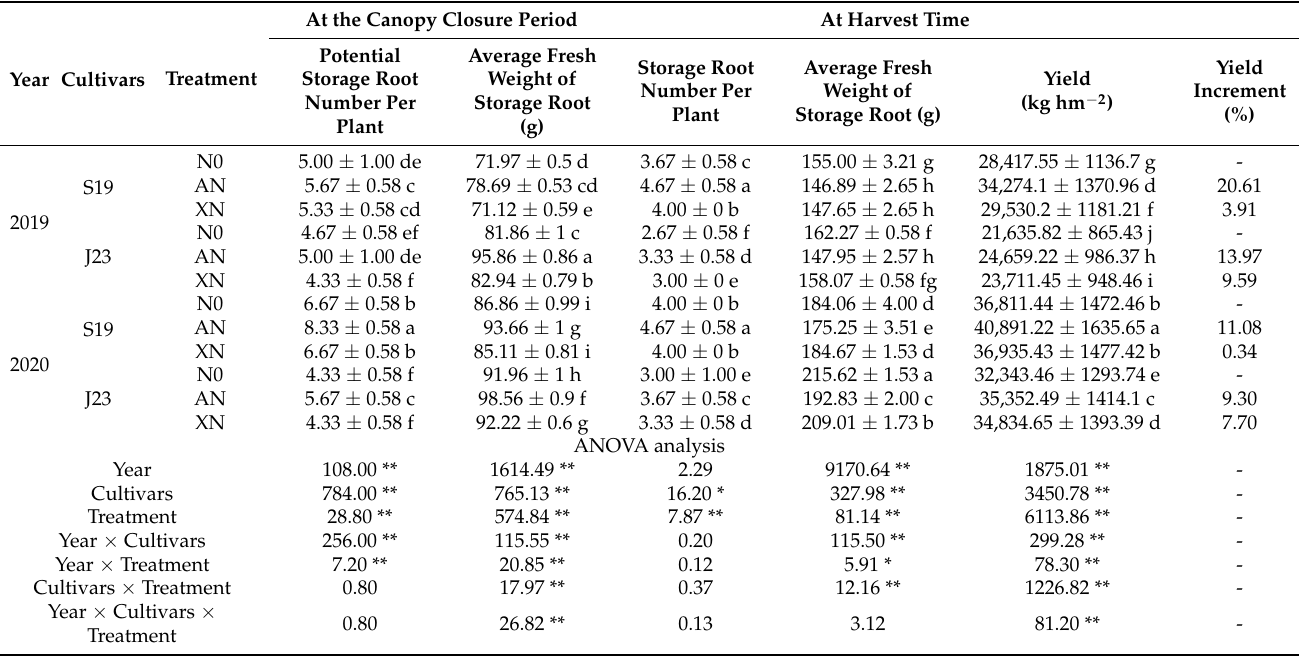
Table 2. Characteristics of the formation of the sweet potato storage root in field trials during canopy closure and harvest period